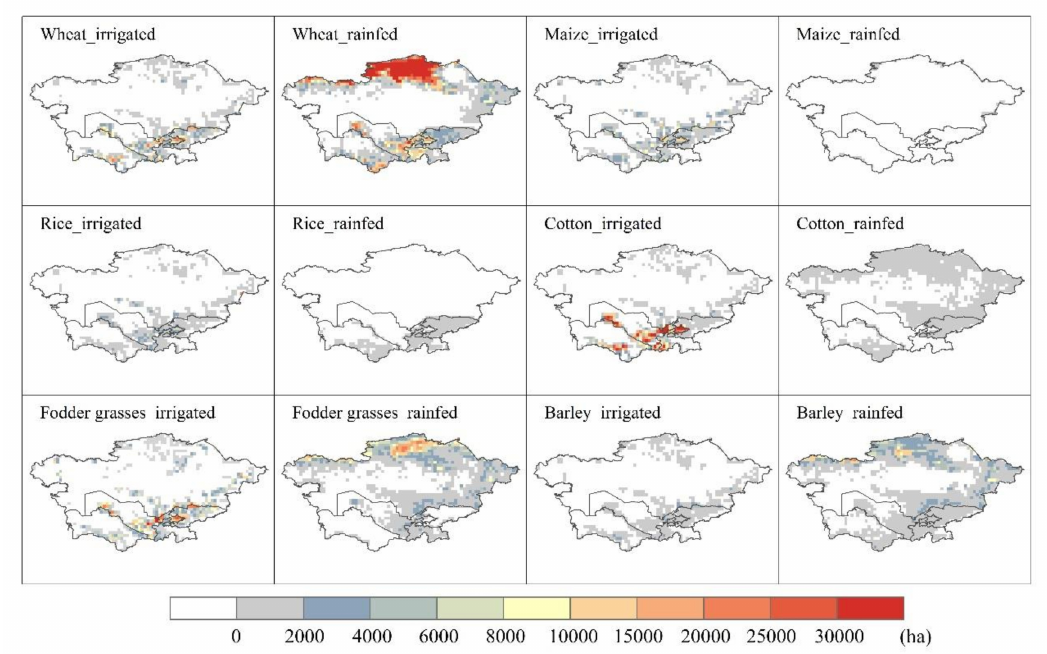
Figure 10. The spatial distribution of harvested areas around the year 2000 for the main crops in Central Asia